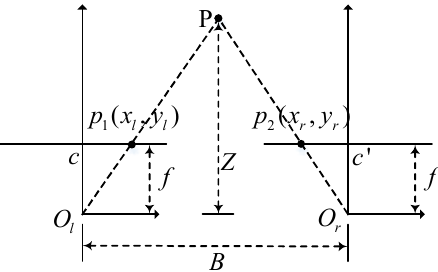
Figure 11. Diagram of binocular vision measurement principle.